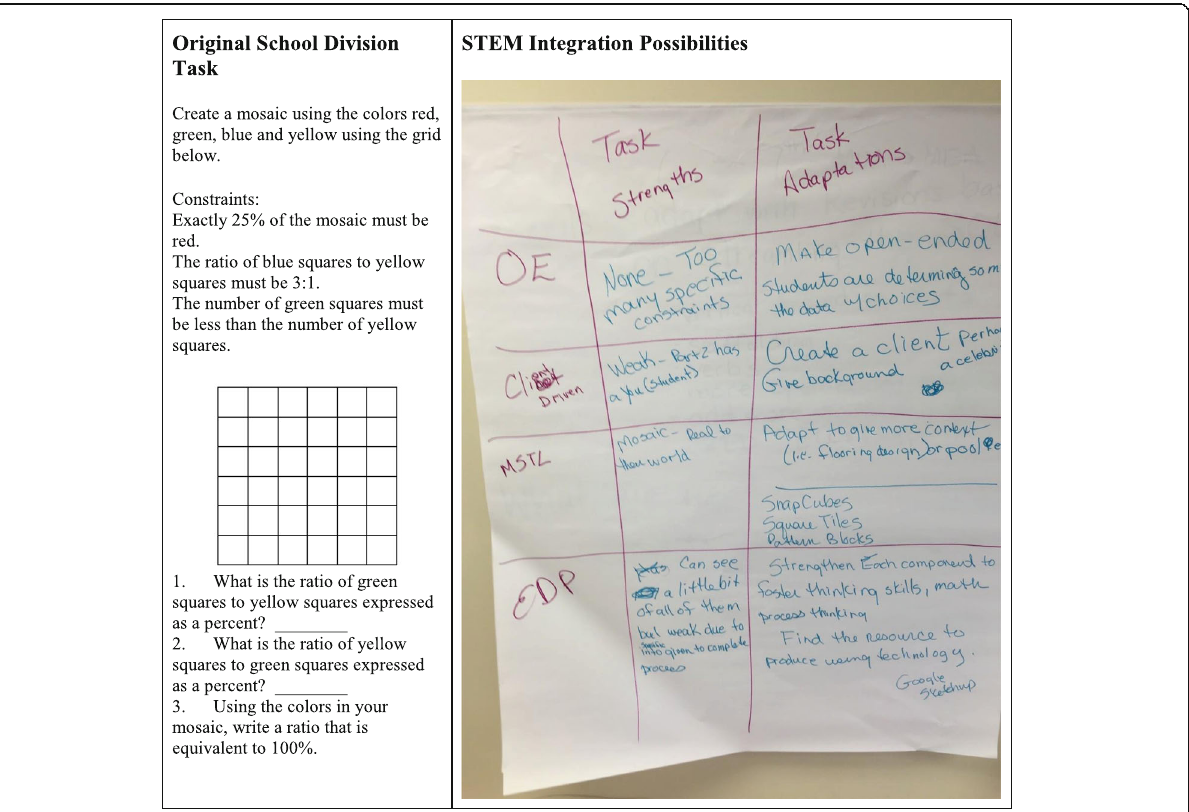
Fig. 4 Small group modifications for the 7th grade mosaic design